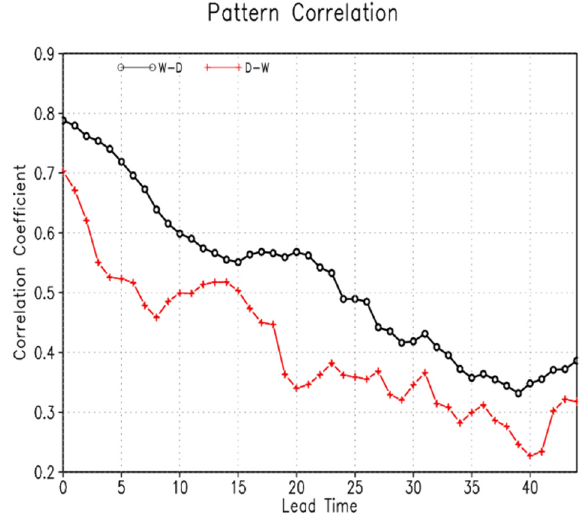
Figure 13. Coefficients of correlation between the differences in rainfall over 30°S–30°N/60°E–160°E for observation (GPCP) and for CFSv2. The black line denotes the correlation coefficients for differences between 28th–29th pentad mean and 25th–26th pentad mean, and the red line denotes the correlation coefficients for differences between 60th–61st pentad mean and 57th–58th pentad mean.